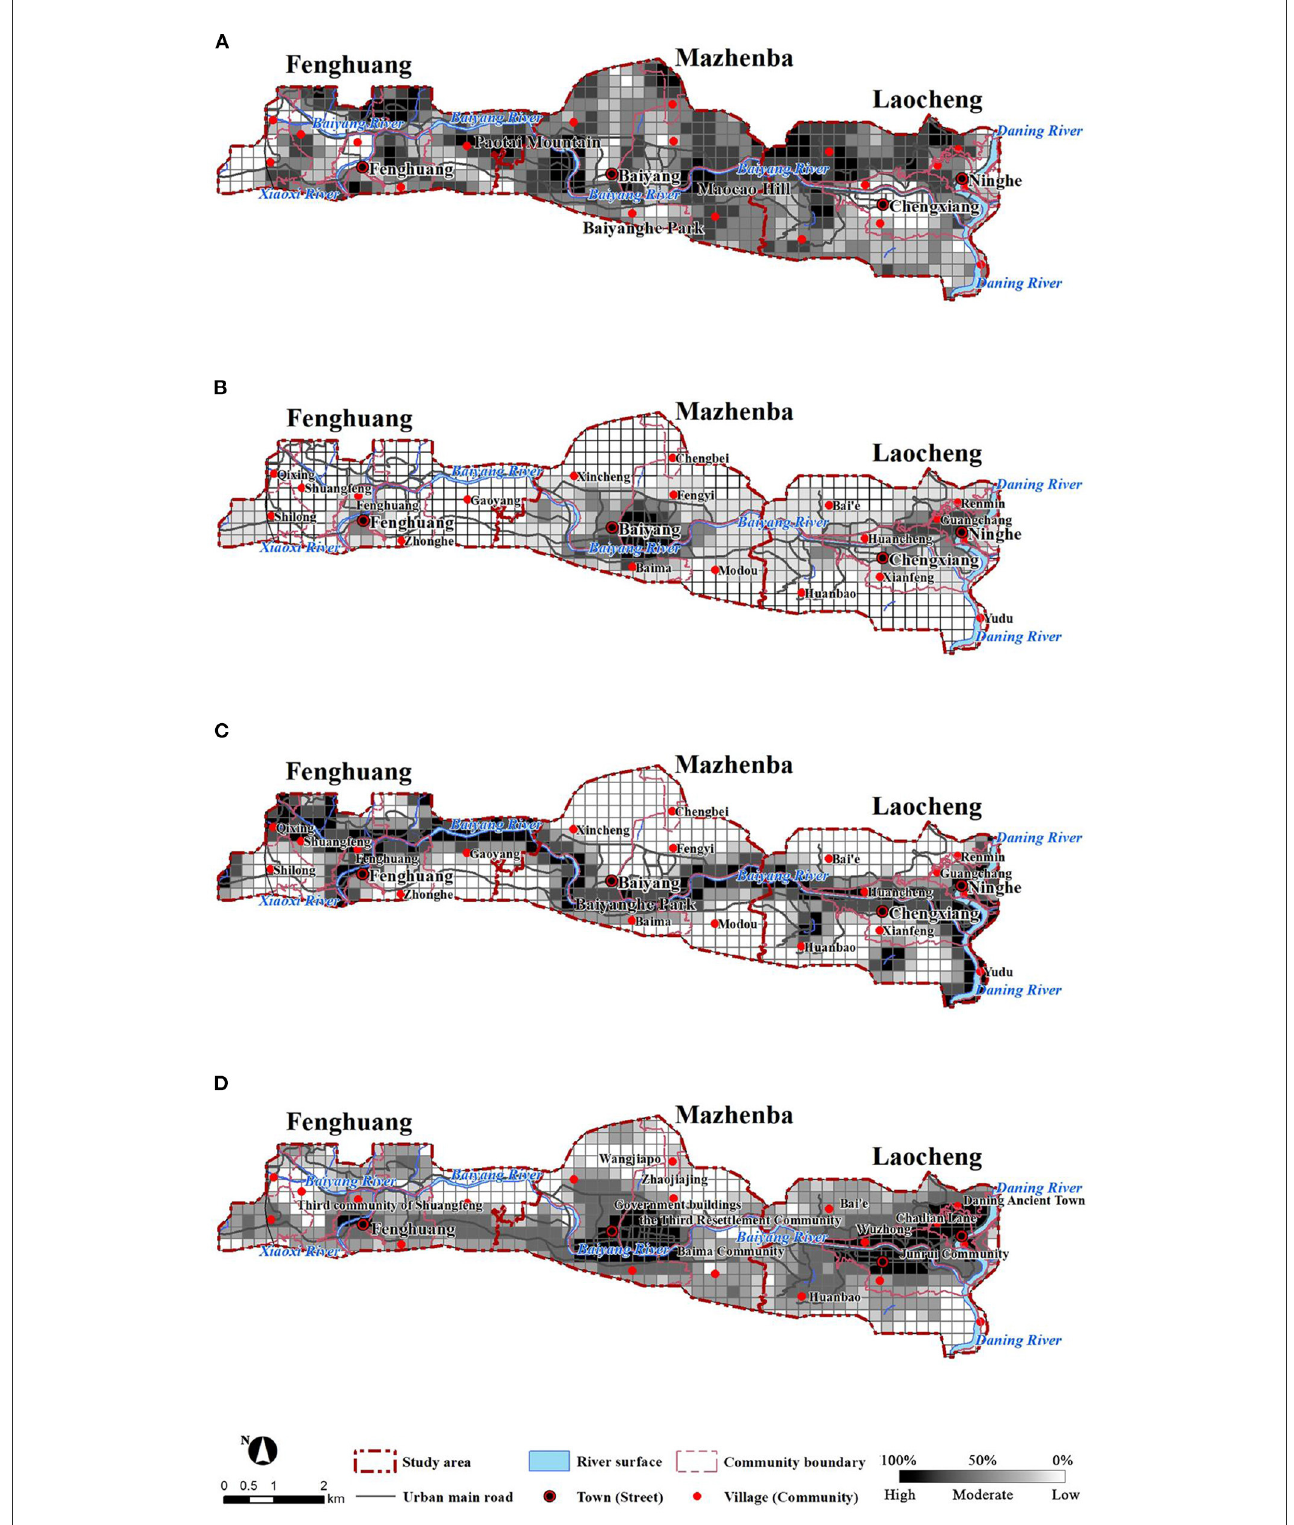
FIGURE2 Distribution of environmental factors: green coverage rate (A) , density of public service facilities (B) , river buffer zones (C) , and comprehensive environmental comfort (D) .